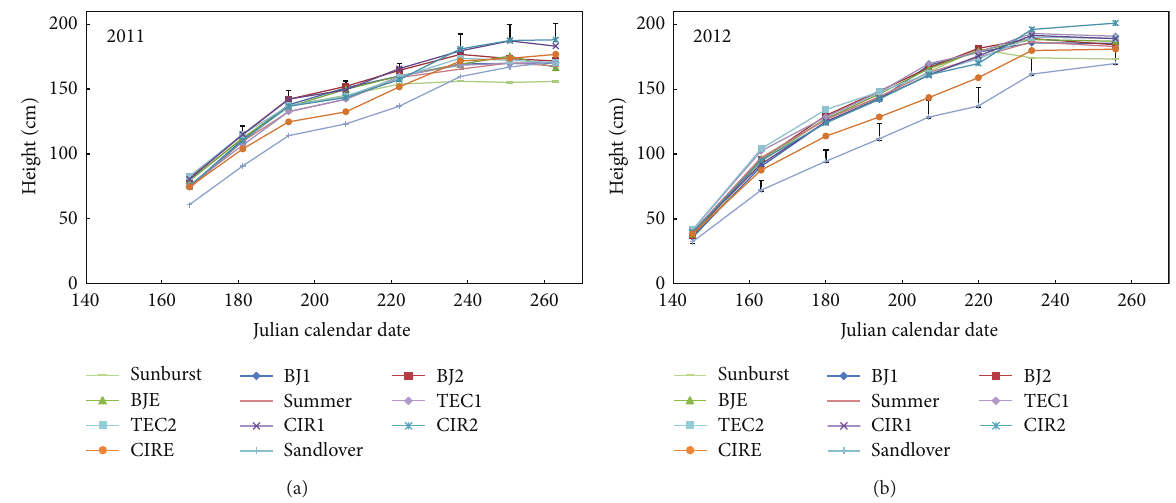
Figure 3: Height of 11 selections of switchgrass at Sainte-Anne-de-Bellevue, Quebec, in 2011 and 2012. Vertical bars represent the least significant difference (LSD, 𝑃 = 0.05 ) at each sampling point throughout the season. BJ1, Blue Jacket; BJ2, Blue Jacket II; BJE, Blue Jacket Early; TEC1, Tecumseh; TEC2, Tecumseh II; CIR, Cave-in-Rock; CIR2, Cave-in-Rock II; CIRE, Cave-in-Rock Early.